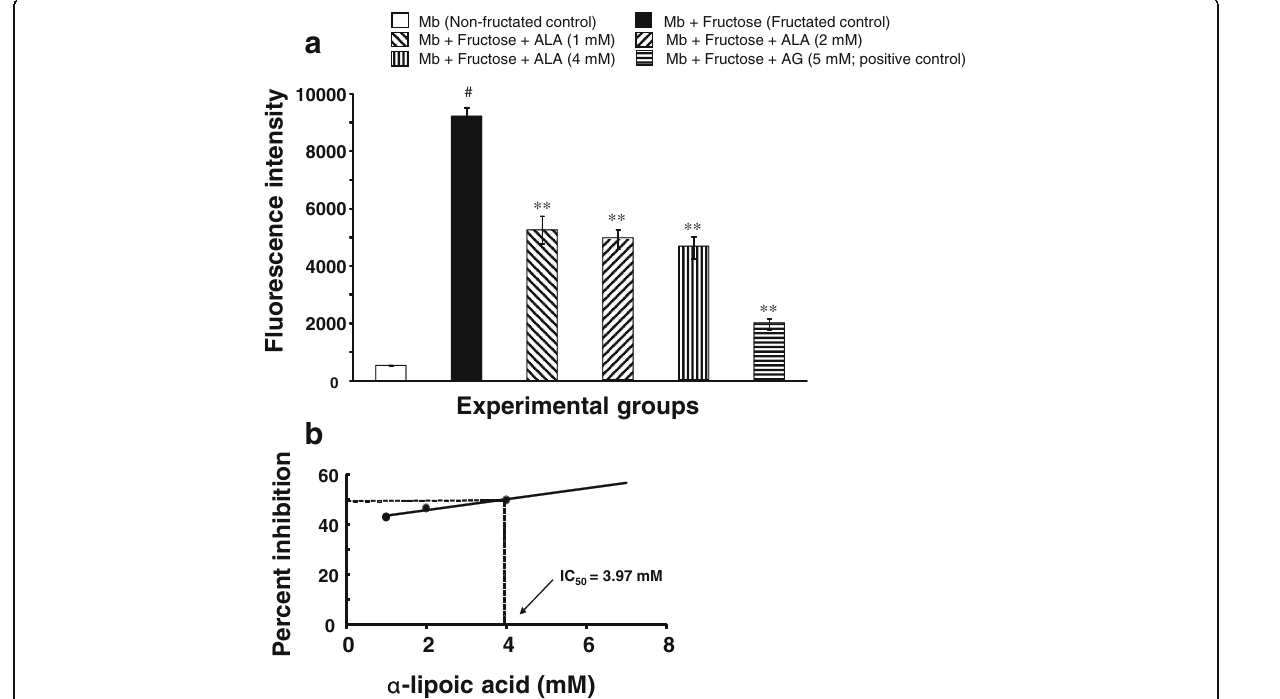
Fig. 1 Effect of α -lipoic acid on the formation of fluorescent AGEs in fructose-induced myoglobin fructation. Each bar represents the mean±SEM in six separate experiments ( n =6). Significant difference from fructated control: ** p <0.01. Significant difference from non-fructated control: # p <0.001. ALA=(R)- α -lipoic acid; AG=Aminoguanidine;